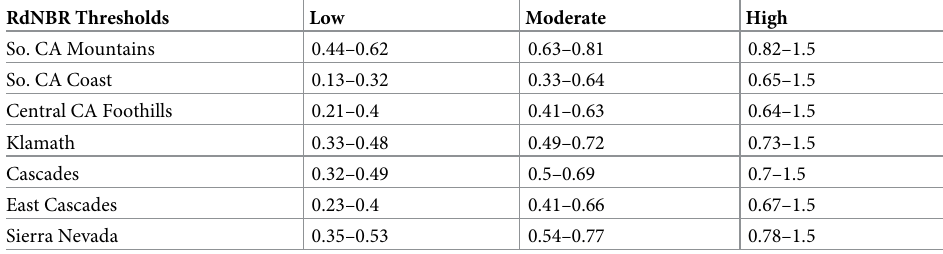
Table 3. RdNBR low, moderate, and high burn severity thresholds for each ecoregion derived from RdNBR cumu- lative